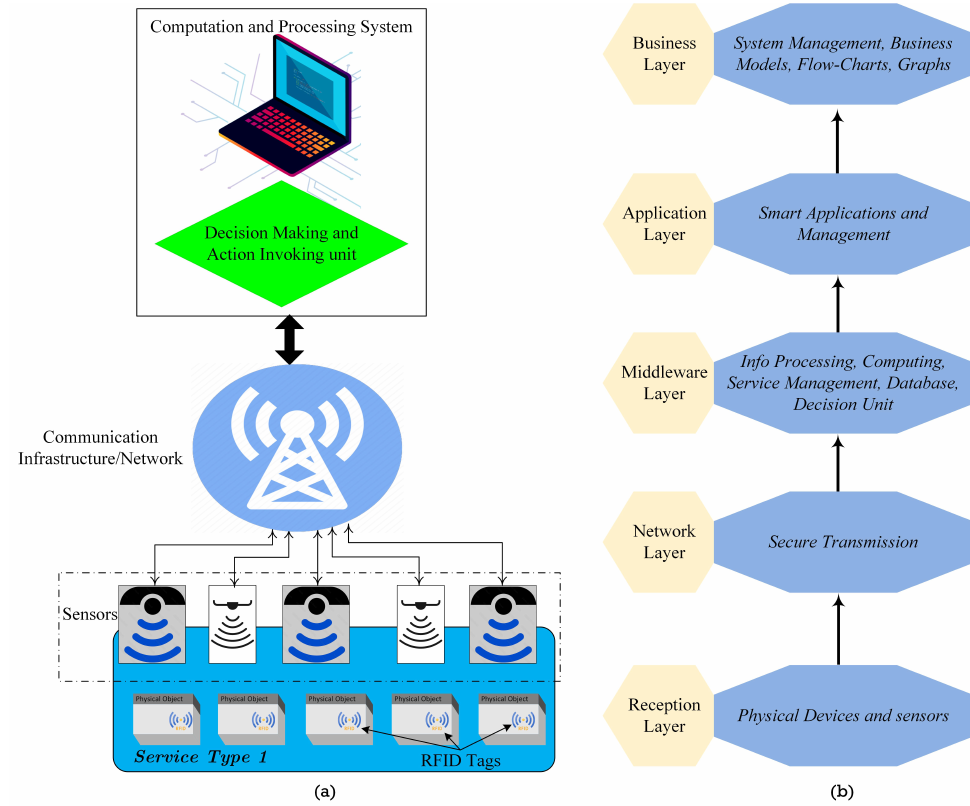
Figure 3. Illustration of IoT structure ( a ) showcasing each fundamental block, and ( b ) IoT structural layers, comprised by sensing and data acquisition, up to system